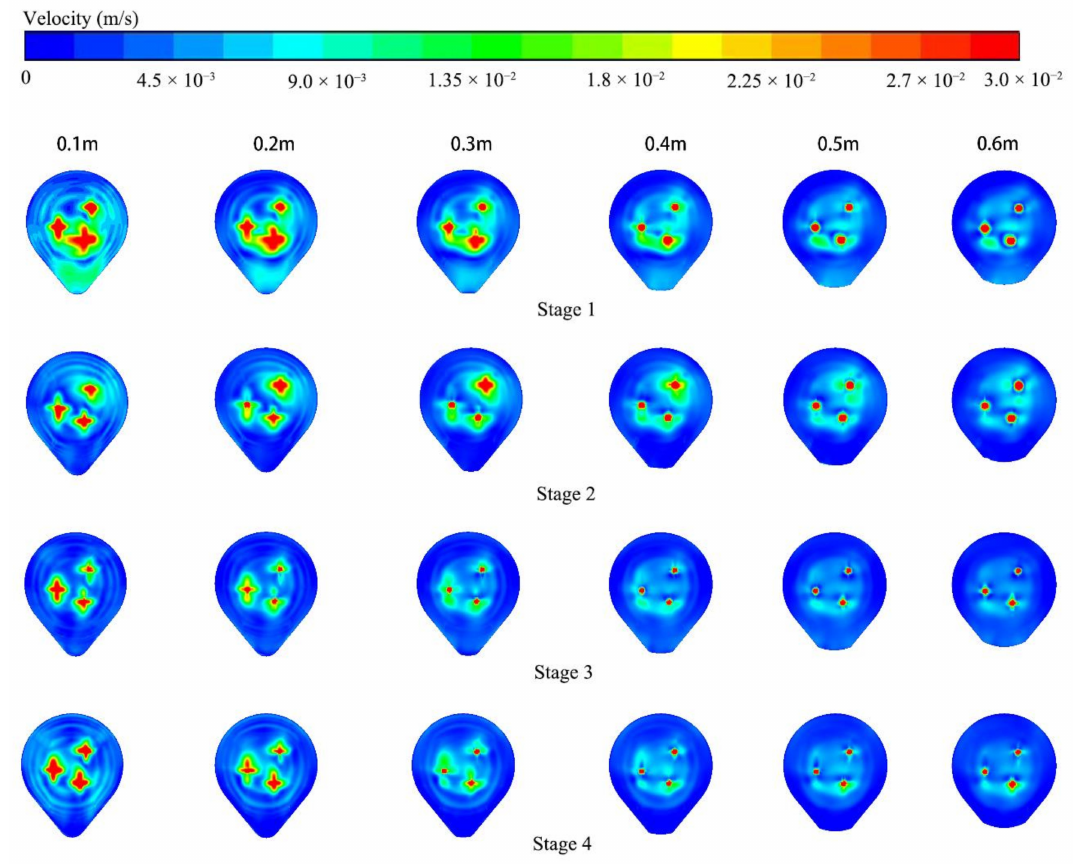
Figure 3. Speed cloud map of each interface in different smelting stages. Table 3. Average flow velocity of molten steel at different smelting stages. Number of Smelting